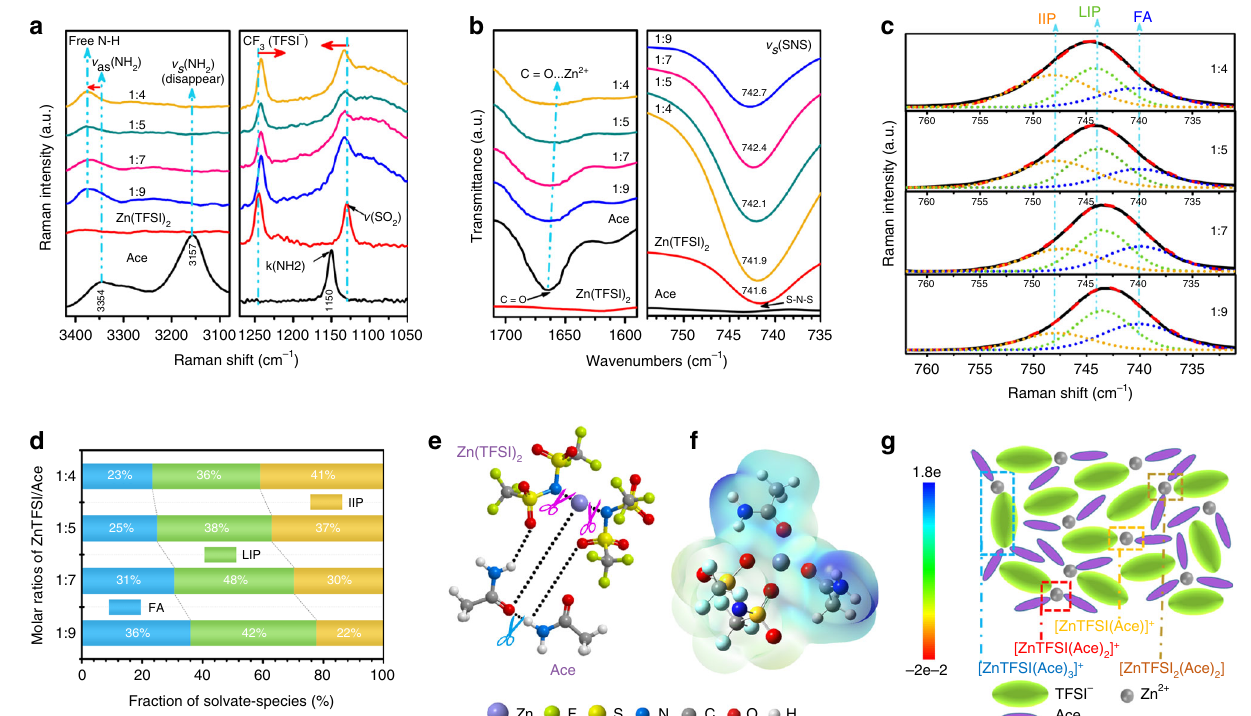
Fig. 1 Structure analysis of ZESs and identity of the ionic species. a Raman, b FTIR, and c Fitted Raman spectra of ZESs with different Zn(TFSI) 2 /Ace molar ratios (1:9 – 1:4). Solid and dashed lines denote experimental spectra and fi tting curves, respectively. d Solvate species distribution in ZESs (free anions (FA), loose ion pairs (LIP) and intimate ion pairs (IIP)), all obtained from the fi tted Raman spectra. e Schematic diagram of the interplay among Zn 2 + , TFSI − , and Ace to form eutectic solutions. f Molecular electrostatic potential energy surface of [ZnTFSI(Ace) 2 ] + ( C 2 -O- П , bidentate coordination of TFSI − ) based on density functional theory (DFT) simulation. Electron density from total self-consistent- fi eld (SCF) density (isoval = 0.001). g Illustration of representative environment of active Zn species within the